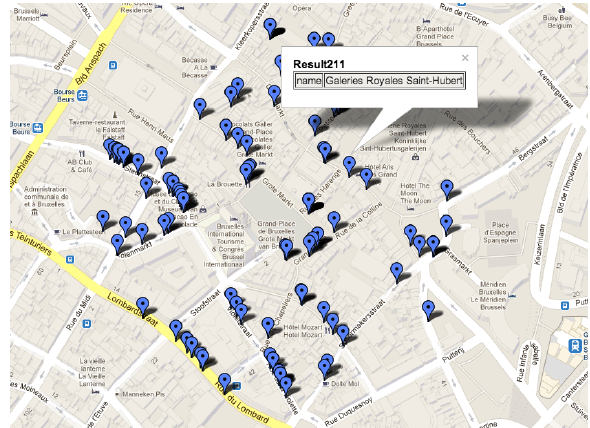
Figure 5. Institutions < 200 m from Grand